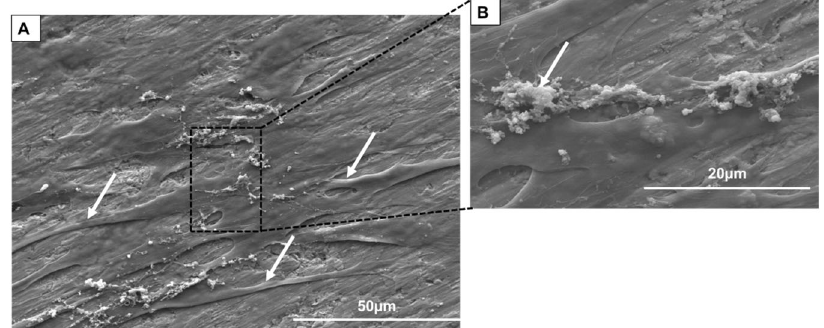
Fig. 3 Hardness and Maximum strength evaluation by